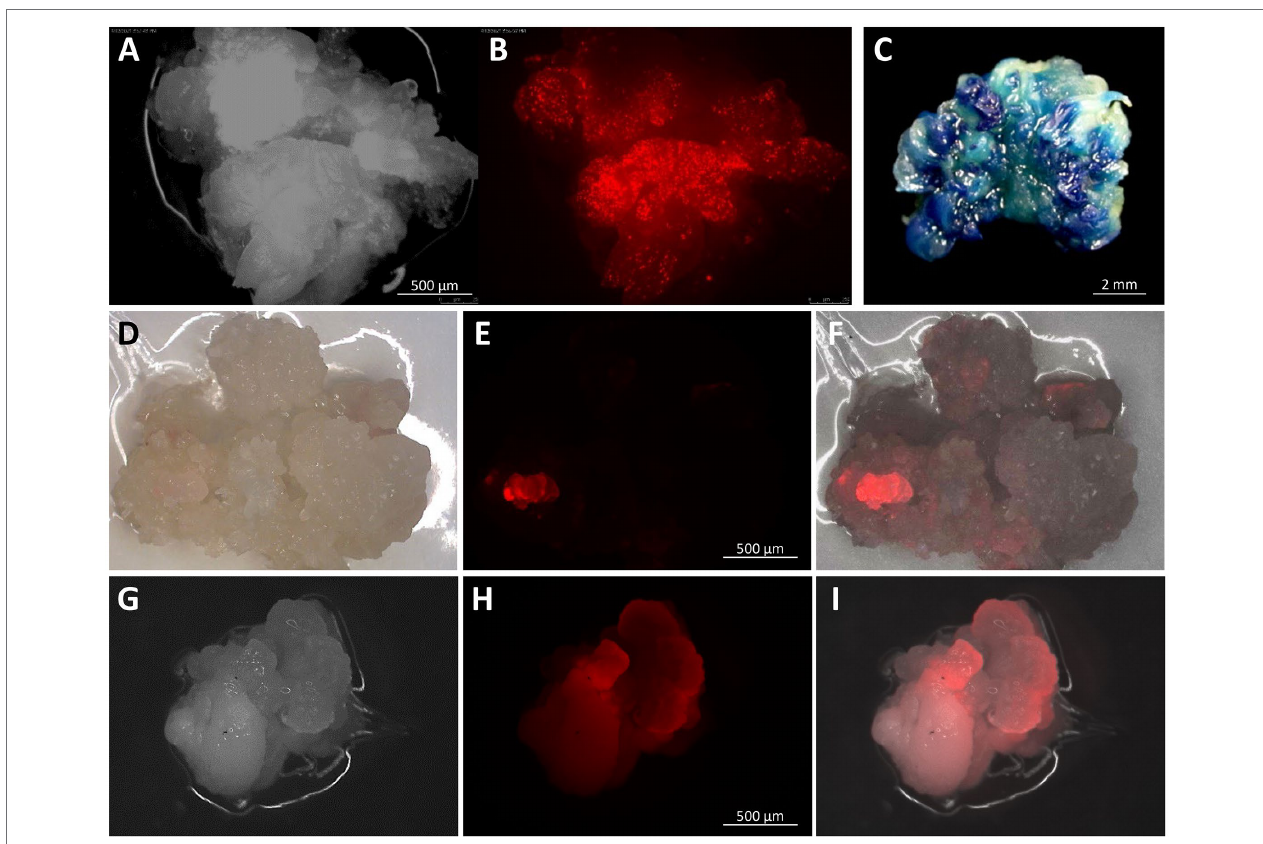
FIGURE 4 | Embryogenic callus at different stages after particle gun bombardment. Embryogenic callus at 4 days after bombardment with pKL2155 under a bright field (A) and under red fluorescent filter (B) showing transient expression of the tdTomato gene; a stable pAHC25 callus event expressing the gus gene (C) ; a pKL2155 callus event expressing the tdTomato gene, 63 days (D–F) and 154 days (G–I) post bombardment under bright field (D,G) , red fluorescent filter (E,H) , and merged (F,I) . Images were taken using Olympus SZH10 stereo microscope with Texas red filter (EX 535–585 nm, EM 605–690